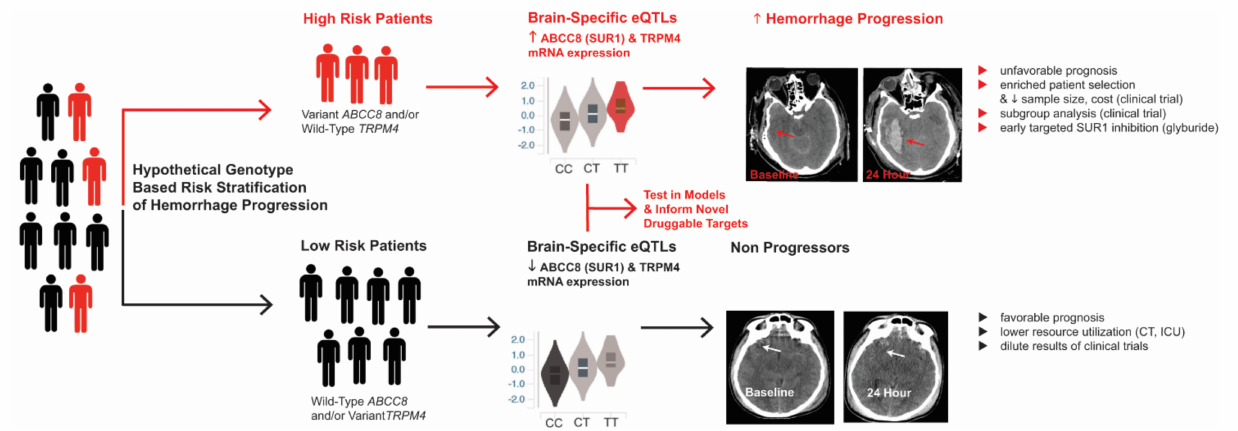
Figure 7. Hypothetical schematic example of precision medicine using genotype-based risk stratification of hemorrhage progression. Patients with high-risk genotypes of ABCC8 or TRPM4 variants (red) may have higher levels of channel mRNA and/or protein expression and in turn be at higher risk of hemorrhage progression after traumatic brain injury. Genotype-based stratification could inform clinician prognostication, enrich patient selection/decrease sample size and cost of clinical trials, guide subgroup analyses, and also be valuable for discovery of novel therapeutic targets based on gene expression/regulation/post translational modifications in this